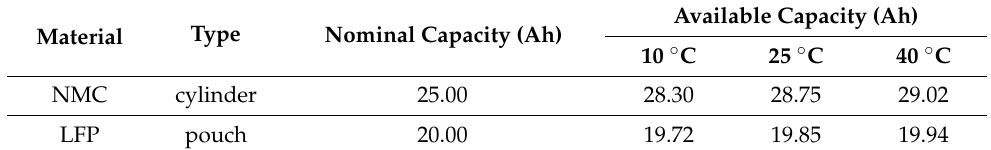
Table 3. Basis information of tested